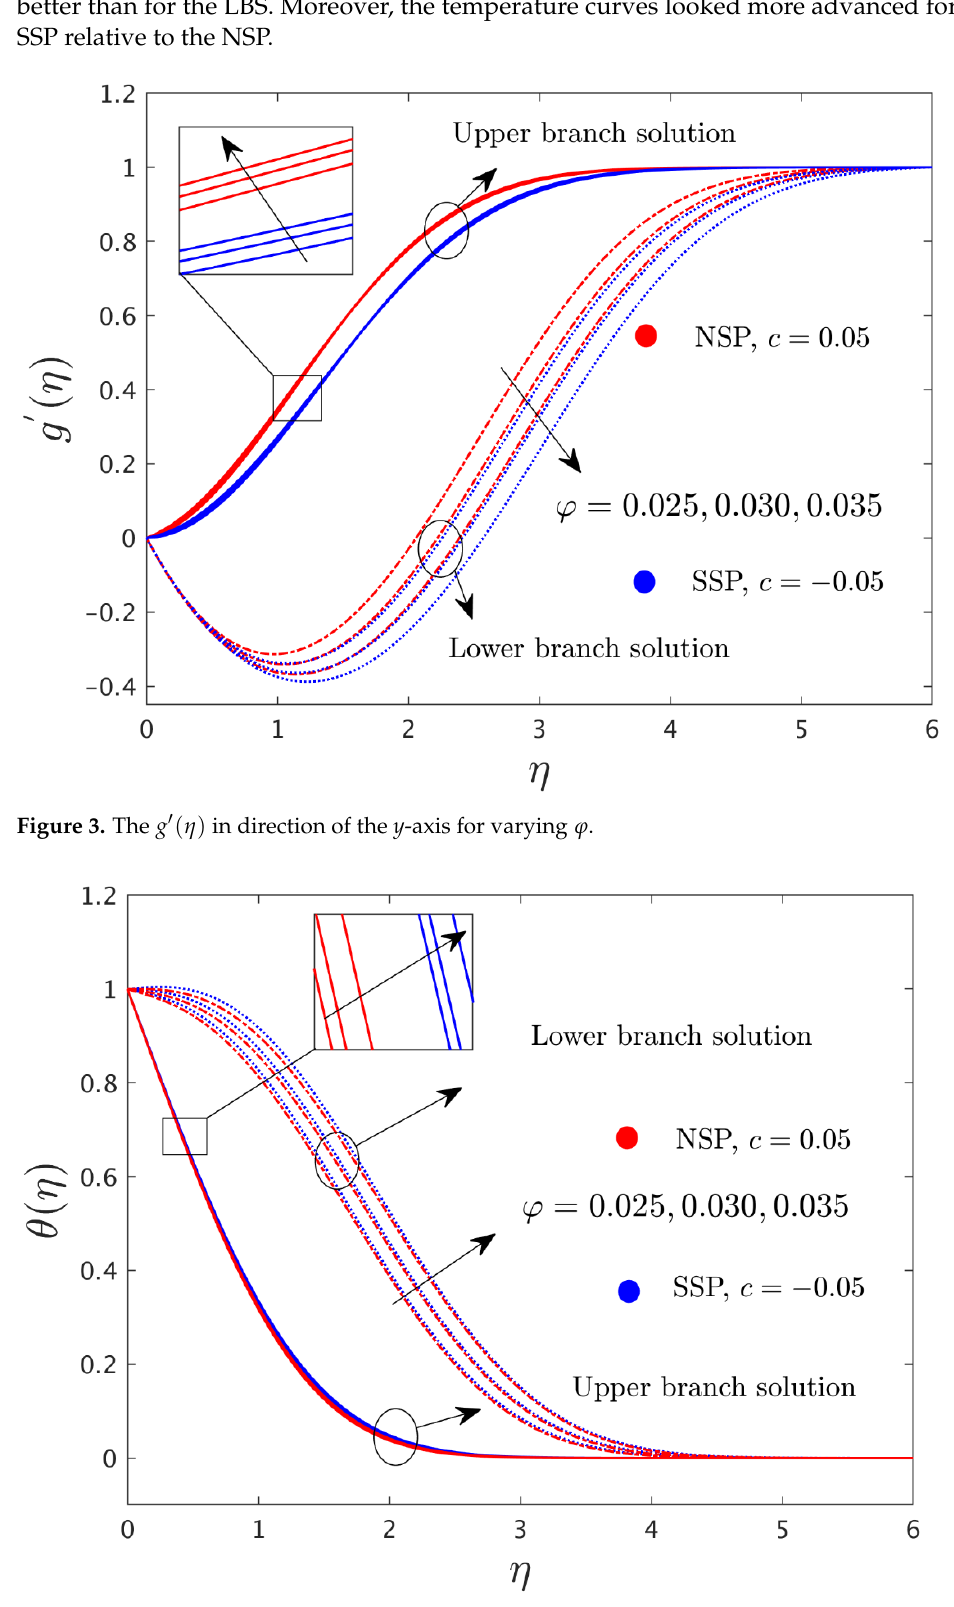
Figure 2. The () '  f in the direction of the x-axis for varying  .